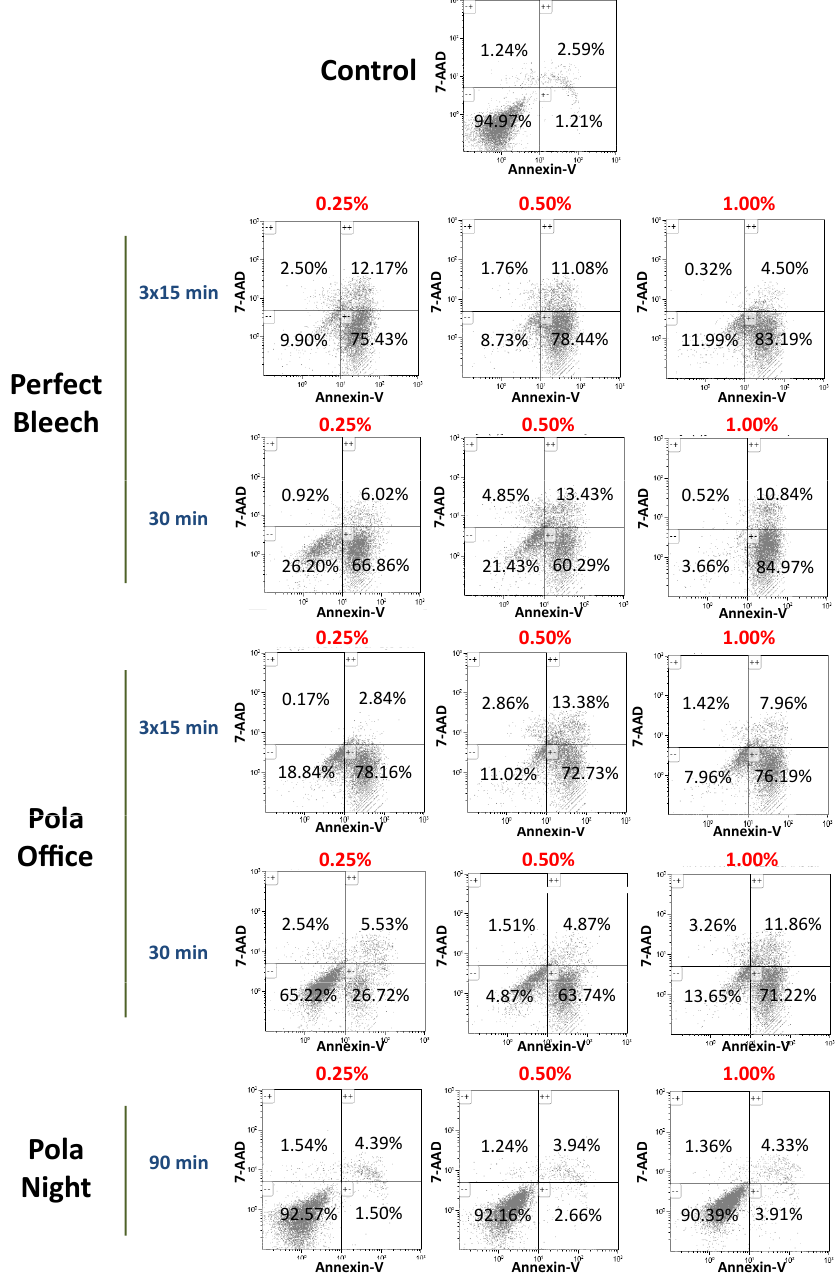
0.5%) of the other bleaching agents decreased cell viability. This cytotoxic effect was minor in the most diluted extracts (0.25%).